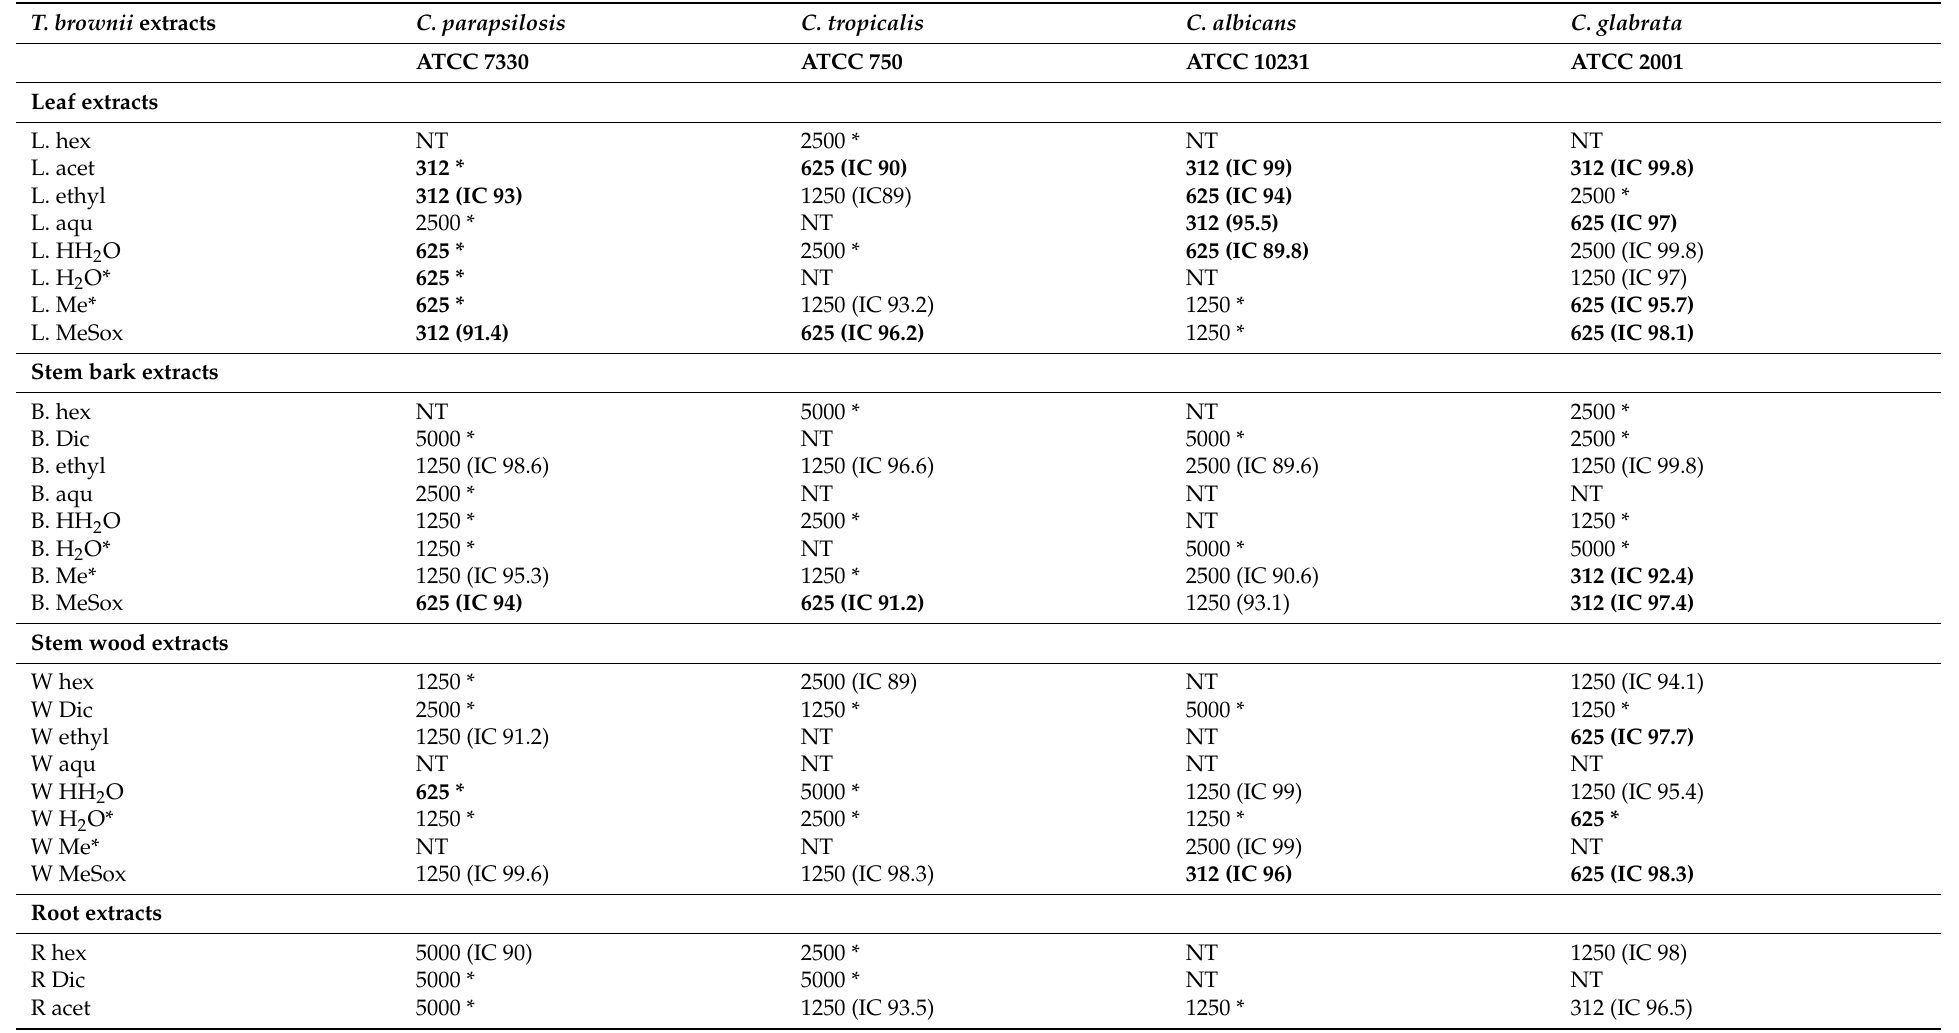
Table 2. Minimum inhibitory concentration (MIC) values of T. brownii extracts and of some pure compounds identified in T. brownii extracts against Candida